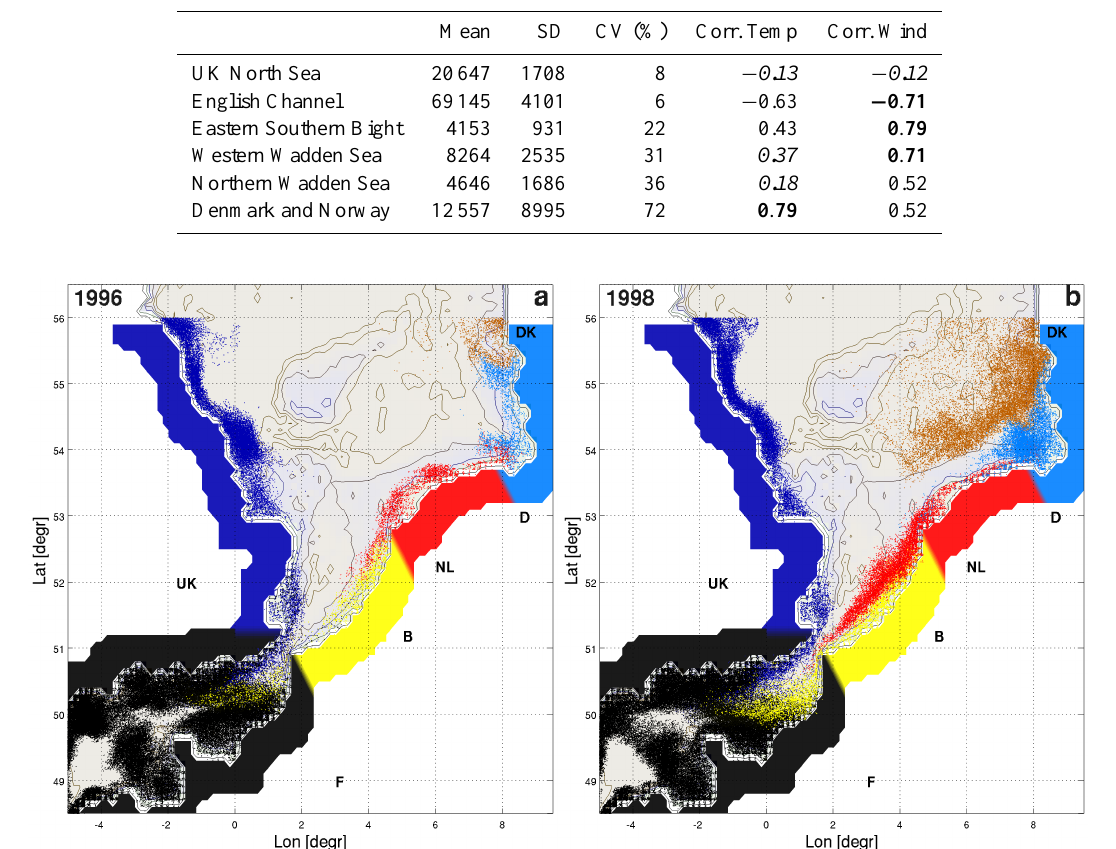
Figure 11: Settle locations of all particles shown in the colour of the dots, for different years ((a) 1996; (b) 1998). For explanation of colour coding see Fig. 7.